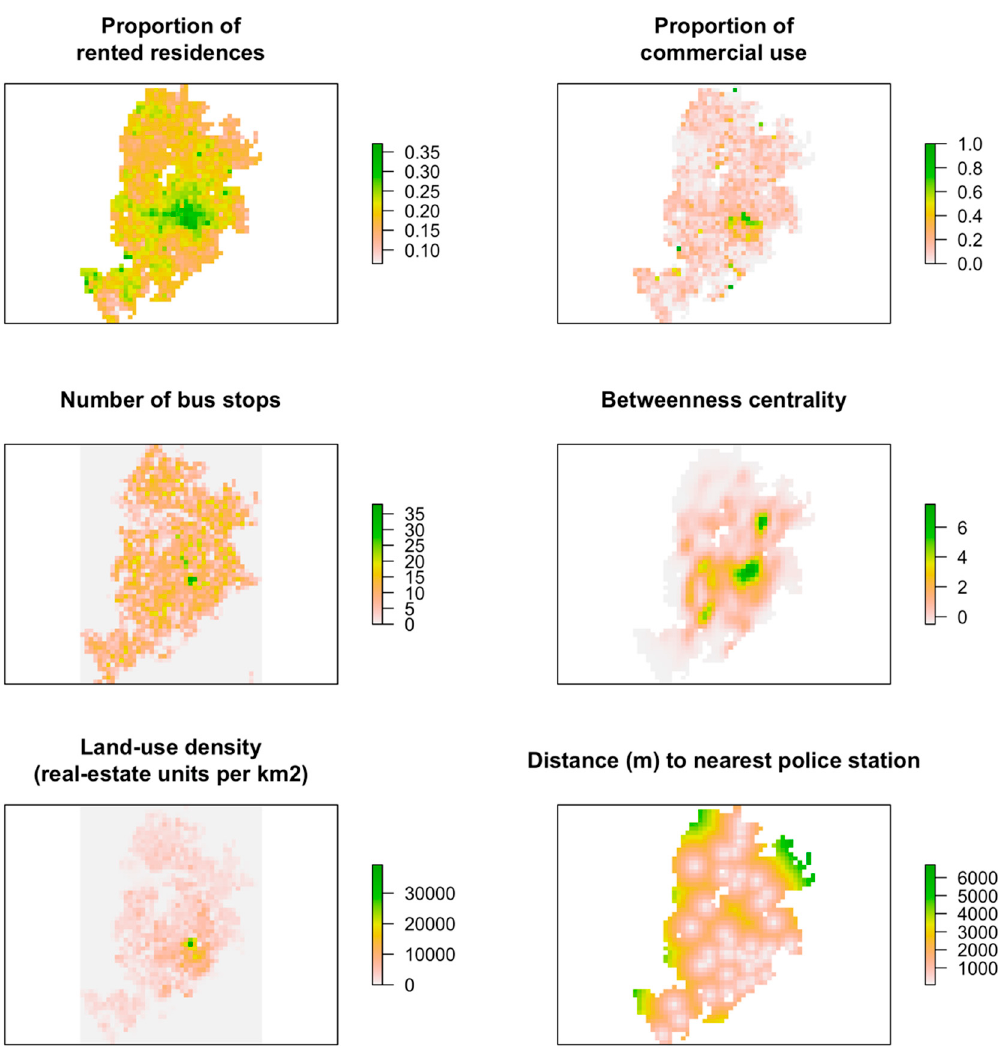
Figure 2. Mapping control variables.